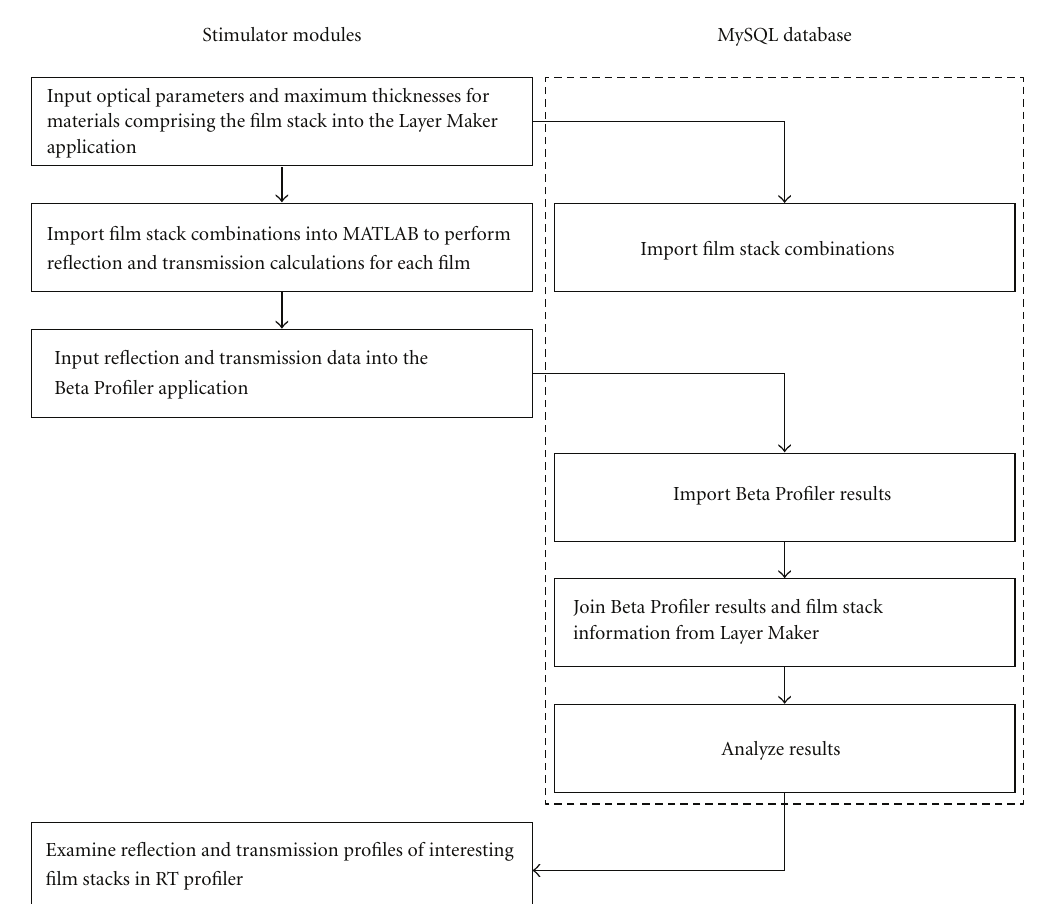
Figure 5: Simulator flow